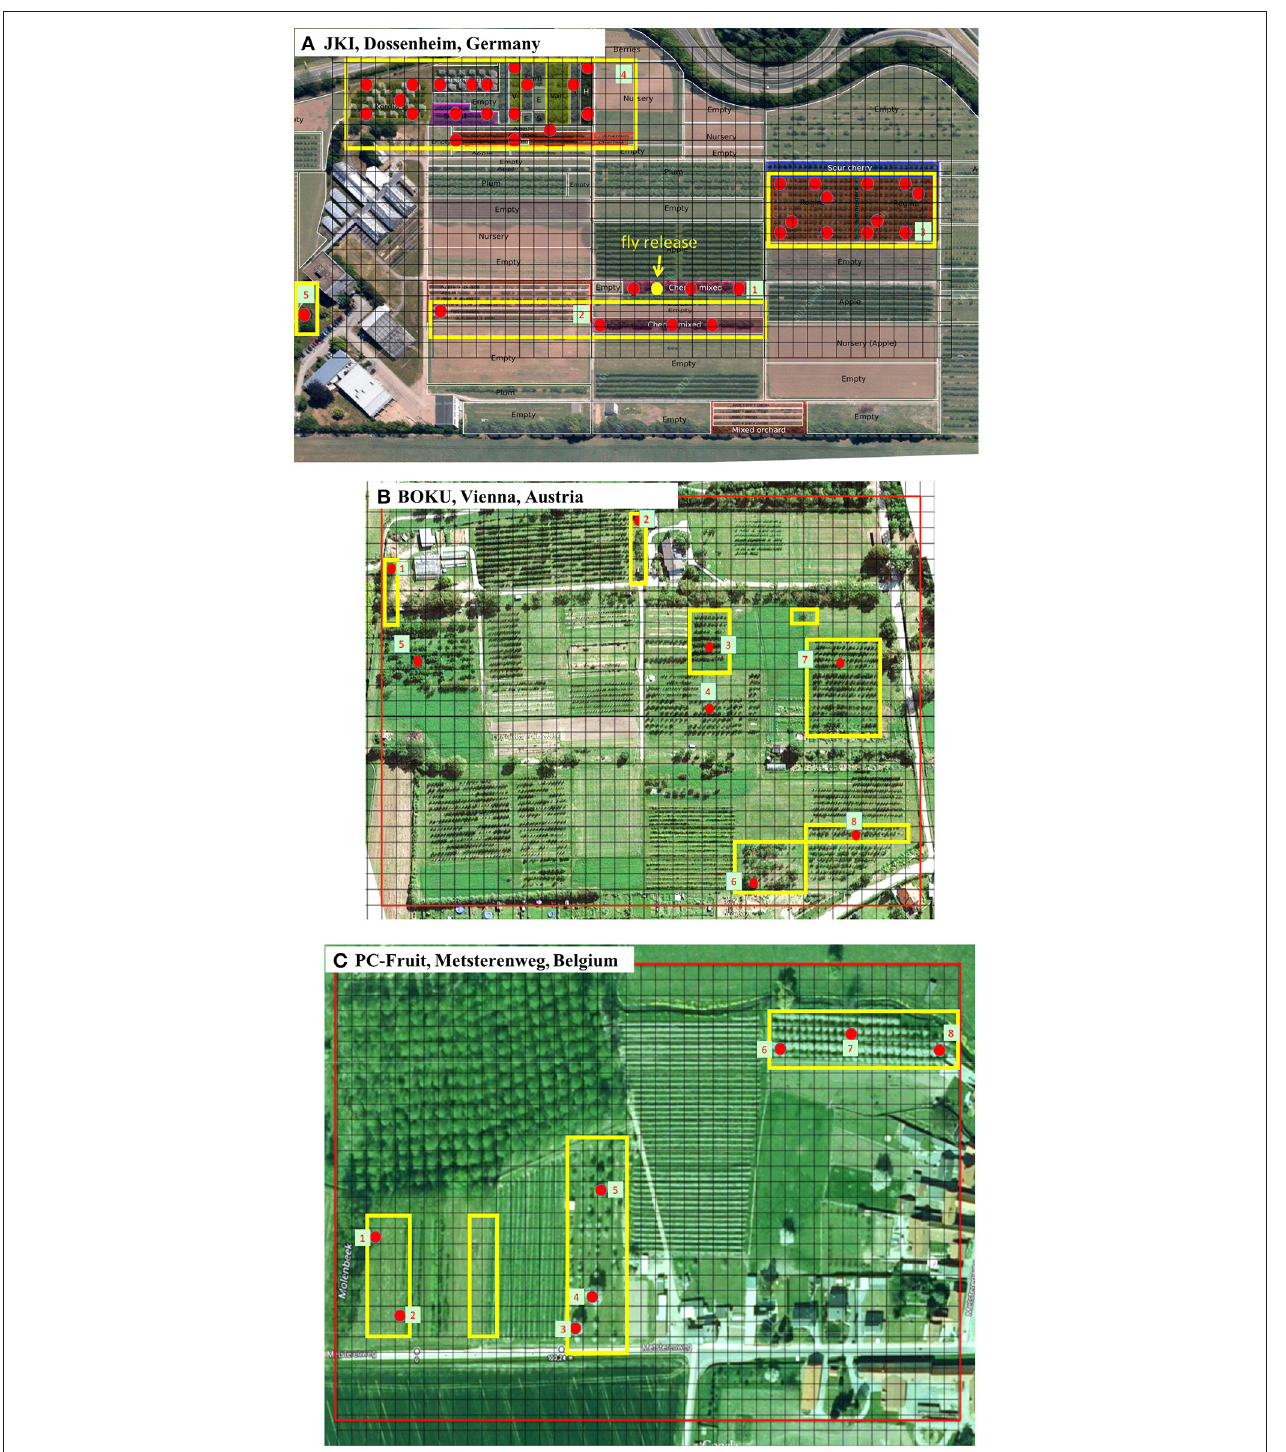
FIGURE 1 | Outline of the experimental farm topography. Red frames: area selected for modeling, Yellow frames: plots containing sweet cherry trees, Red dots: position of the Rebel traps, Grid: farm sectors equivalent to 10 × 10m on the ground, Background map data: Google Maps.